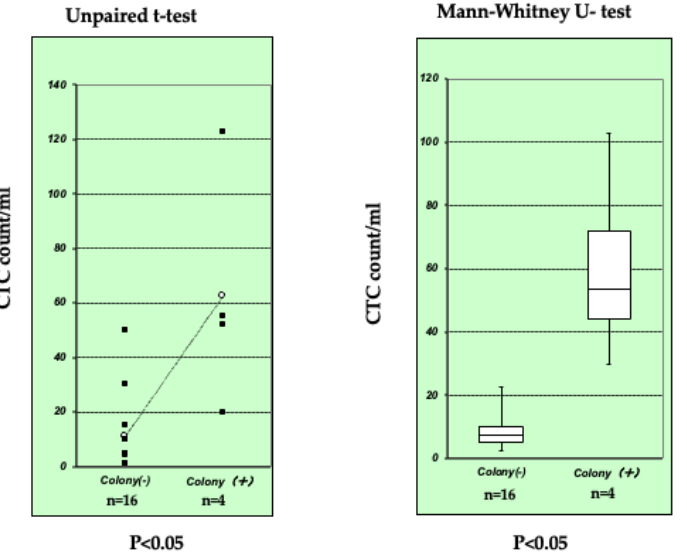
Figure 2. Colony formation by 4 out of 20 samples. The number of samples was too small for a definite evaluation; however, a high CTC count/mL (anti-HEA) was associated with colony formation (an unpaired t -test and the Mann–Whitney U test < 0.05)